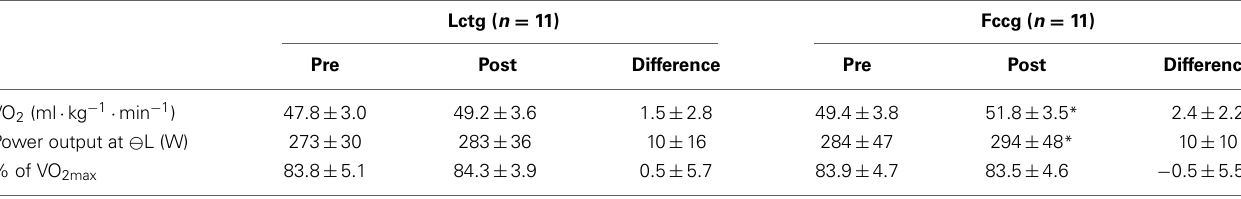
Table 2 | Oxygen consumption (VO 2 ) and power output (mean ± SD ) at the lactate thresholds ( (cid:2) L) (OBLA 4mmol/L) pre and post training intervention period for the low cadence training group (Lctg) and the freely chosen cadence group (Fccg).